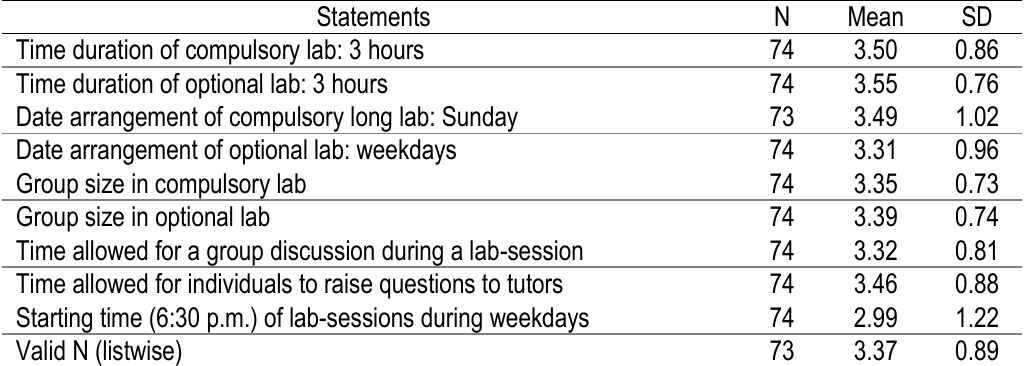
Table 6. Overall Perceptions of the Practical Work